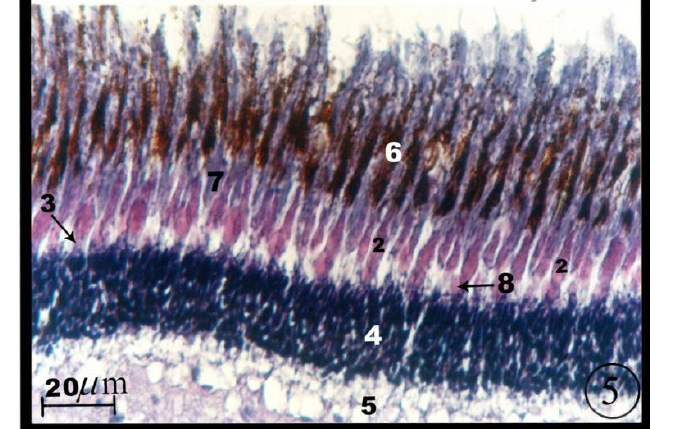
X 400 .1: External Limiting Membrane ; 2: Long Single Cone ; 3: : Myoid Element; 4: Outer